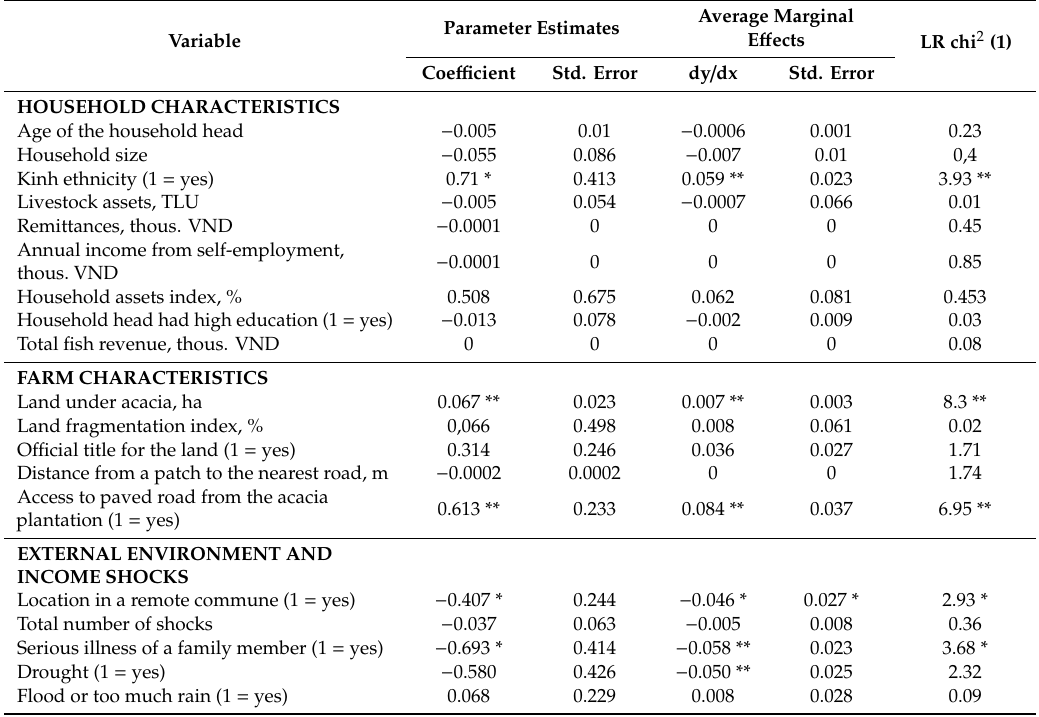
Table 5. Summary of simple probit